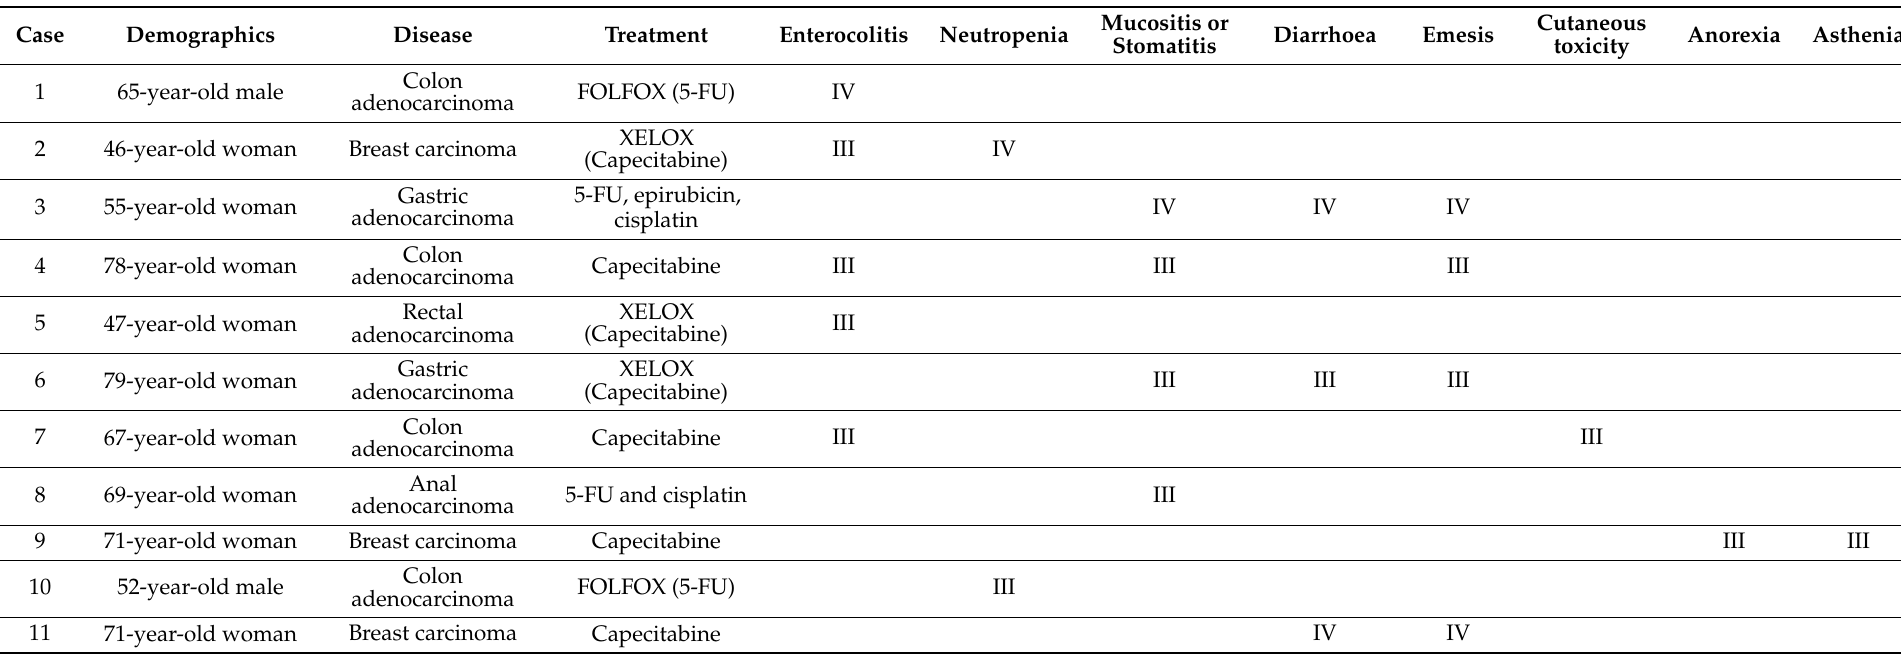
Table 2. Demographics, disease, treatments and types and severity of toxicity reported in the 11 cases of the present study.